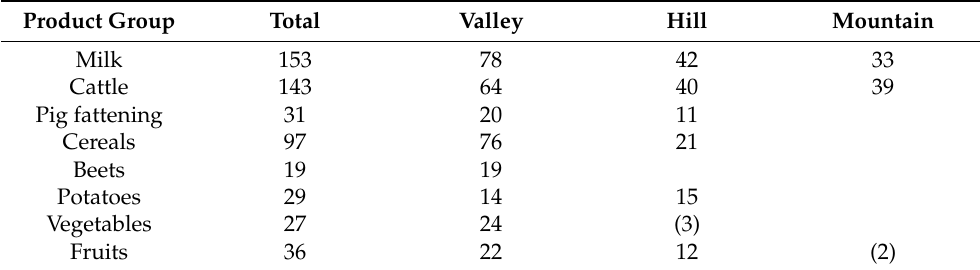
Table 2. Number of observations for product groups and production regions. Counts in parenthesis mark subgroups with not enough observations for the